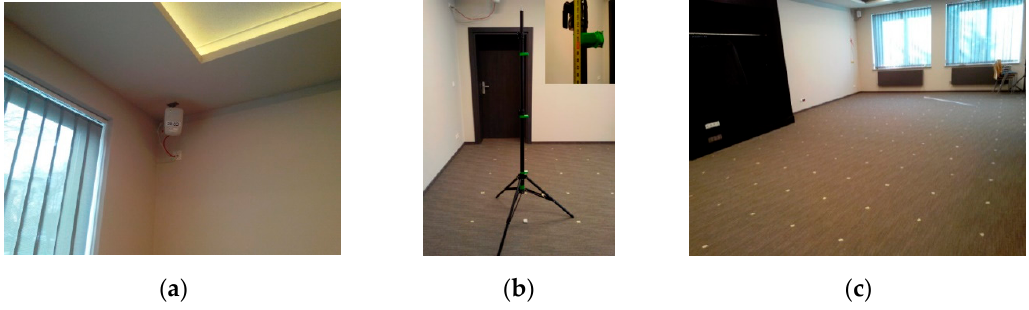
Figure 12. Photos of ( a ) RTLS sensor; ( b ) tripod with mounted tag; and ( c ) indoor environment.